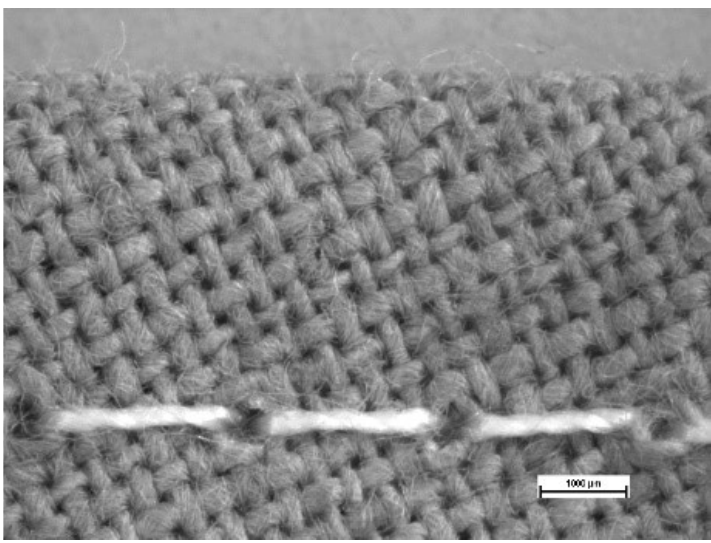
Figure 2. Holes in face mask created by a sewing needle (magnification: 1000 µm).